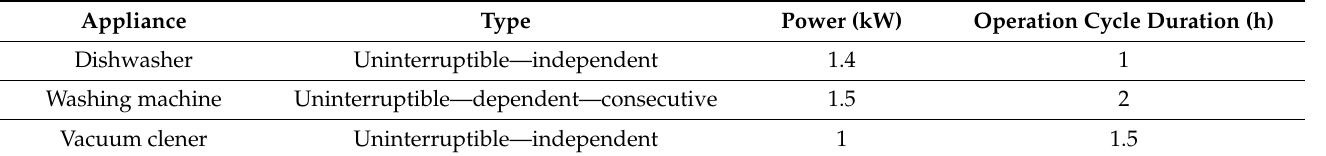
Table 2. The home appliances considered.